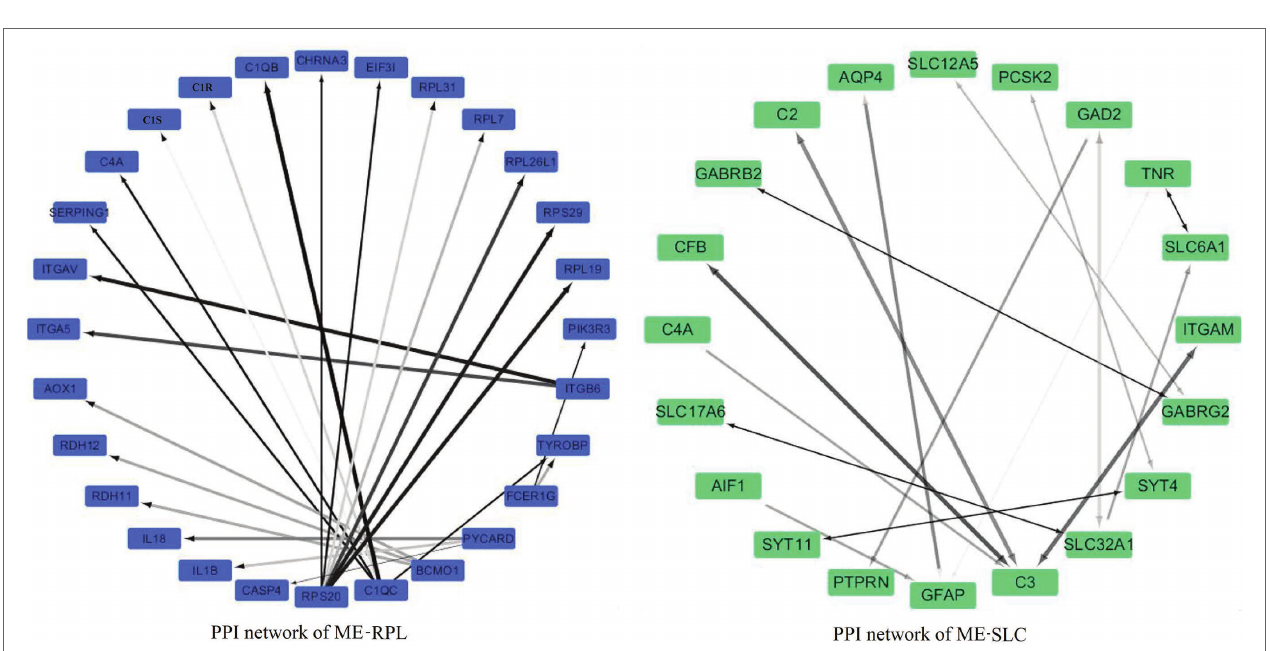
FIGURE 12 | PPI networks of the DEGs in “ME-RPL” and “ME-SLC.” Grayscale value of each line correlates with the strength of the interaction between the proteins.